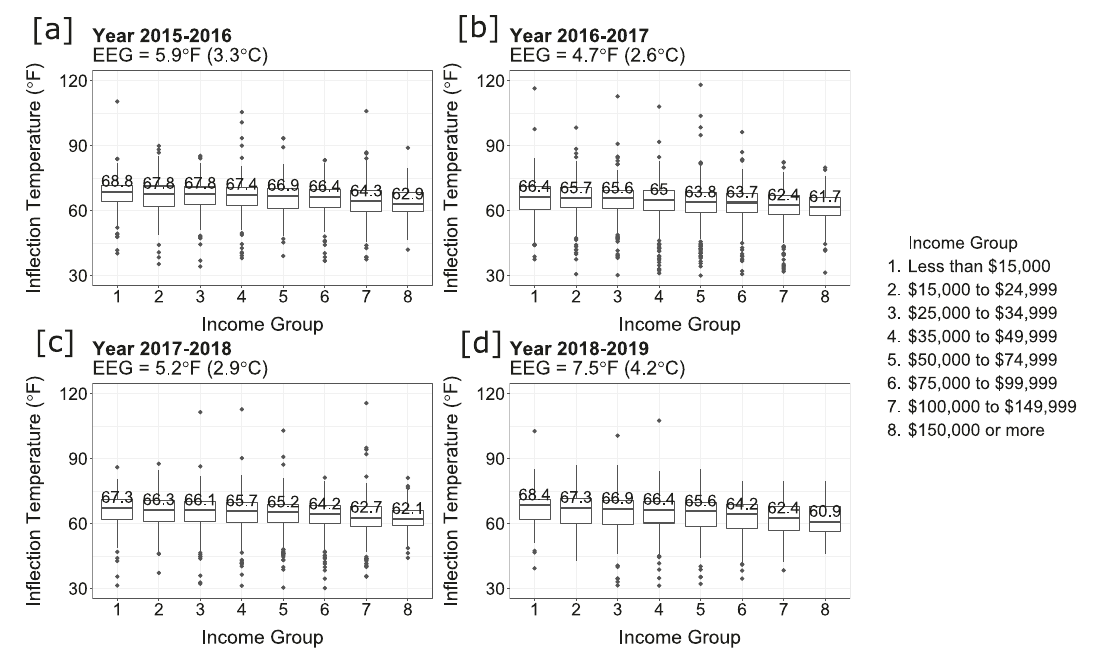
Fig. 3 The distribution of in fl ection temperature across income groups. The energy equity gap (EEG) for each year is calculated as the difference between the highest and lowest median in fl ection temperature (indicated by the middle bar and number) among all income groups in all four panels, income group 1 had the highest, and income group 8 had the lowest median in fl ection temperature. The energy equity gap (EEG) is shown at the top of each panel. ( a ) 2015 – 2016 N = 4577 households, ( b ) 2016 – 2017 N = 4522 households, ( c ) 2017 – 2018 N = 3852 households, ( d ) 2018 – 2019 N = 2650 households. Each box and whiskers plot indicates the minima and maxima of in fl ection temperatures of one income group for one year (the lower and upper bound of the whiskers), the fi rst and third quantiles (the lower and upper bound of the box), and the median (the middle line). The outliers are shown as dots on either side of the whiskers. Source data can be found in our code repository.